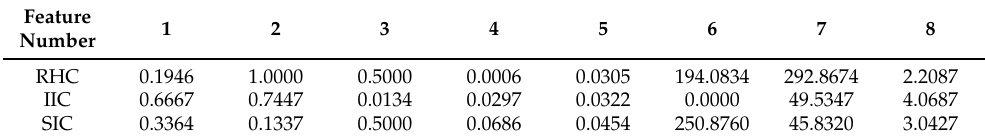
Table 5. Feature bandwidths by model typology and feature